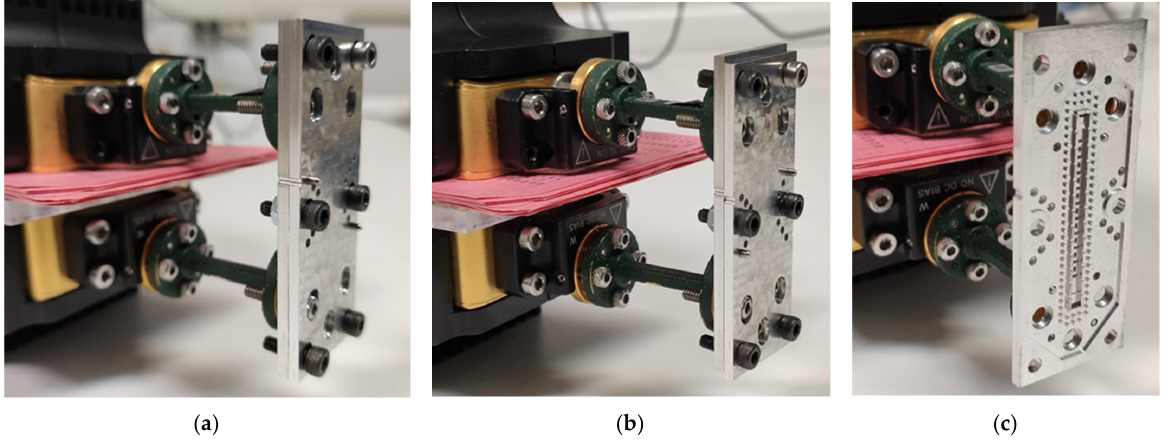
Figure 33. Images of the measuring and assembly equipment. ( a ) VNA and frequency extender, ( b ) measurement heads and ( c ) filter measurement set-up.